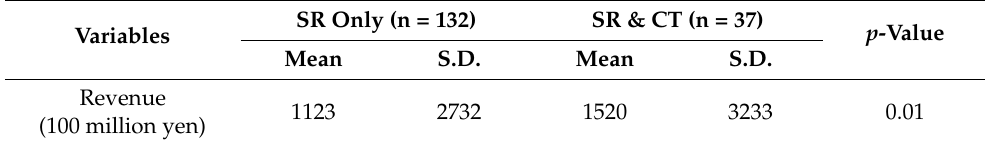
Table 3. Corporate revenue of 169 companies by notification route.